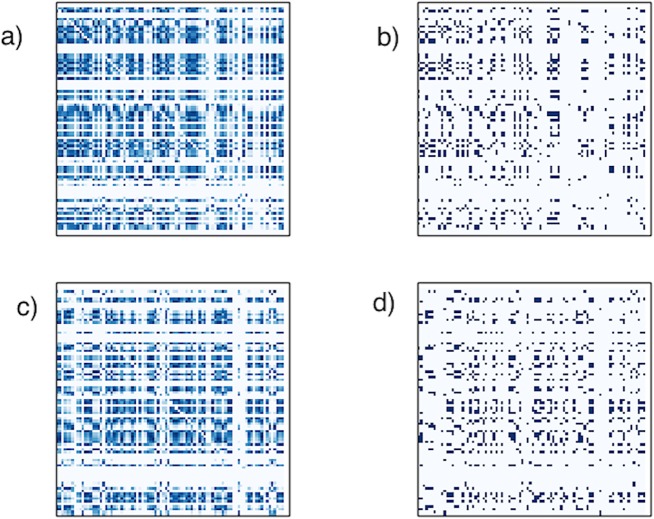
DPNet matrices.(a) Connectivity heat map for sample NC patient DPNet matrix. Note that it is not symmetric, as the connections are directed and has horizontal bands that reflect nodes that might be infected in the early period. (b) Matrix representation of thresholded DPNet network for NC patient. (c) Connectivity heat map for sample AD patient DPNet matrix. (d) Matrix representation of thresholded DPNet network for NC patient.